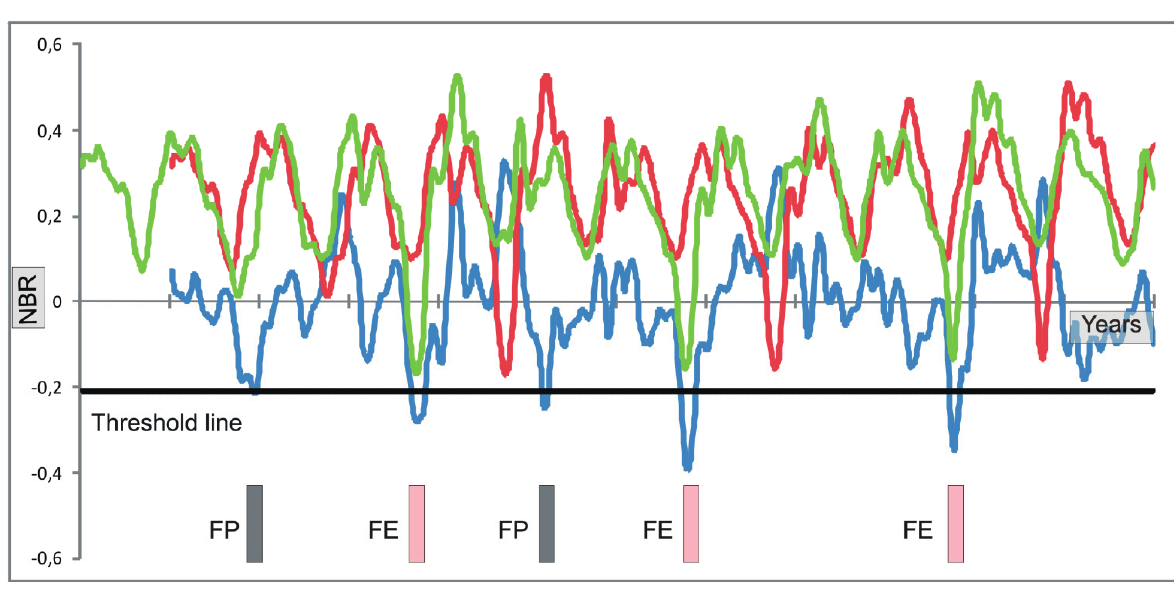
Figure 21. Detection of burned areas using the seasonal difference method, where the MODIS-NBR time series is the green line, the time series with a one-year lag is the red line, the dNBR curve is the blue line and the threshold line is the black line. Fire events (FE) and false positive (FP) are marked on the bottom of the chart.